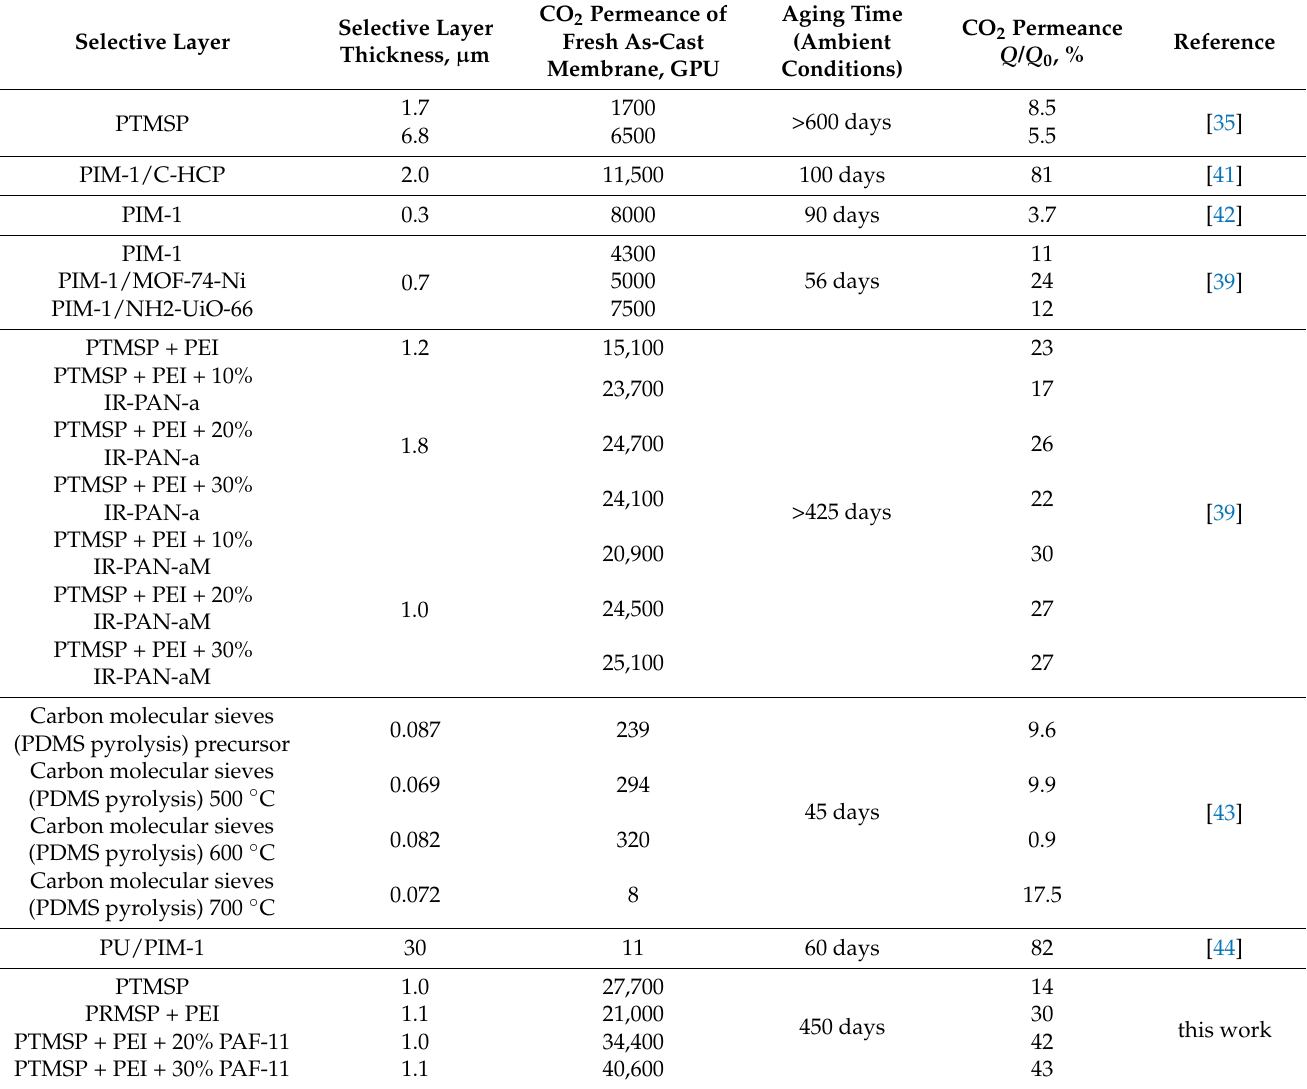
Table 2. Comparison of the TFC membranes’